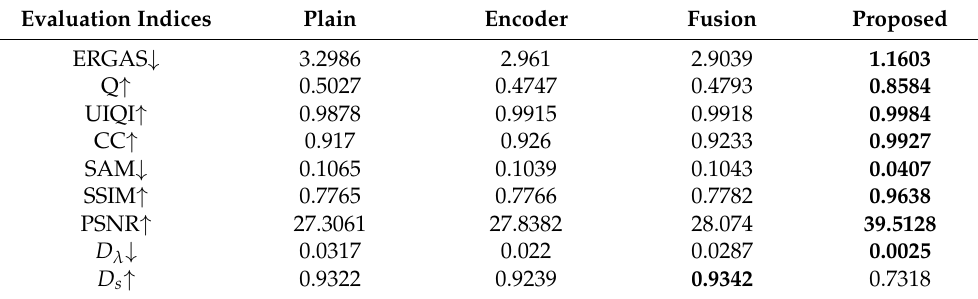
Figure 4. Comparison results of different attention strategies (downsampled GF-2 image of Henan Province, China). ( a ) LRMS image. ( b ) HRPAN image. ( c ) Reference MS image. ( d – g ) Pansharpening result of plain network, encoder attention, fusion attention and the proposed method. Table 3. The quantitative results of different attention strategies (downsampled GF-2 image of Henan Province,